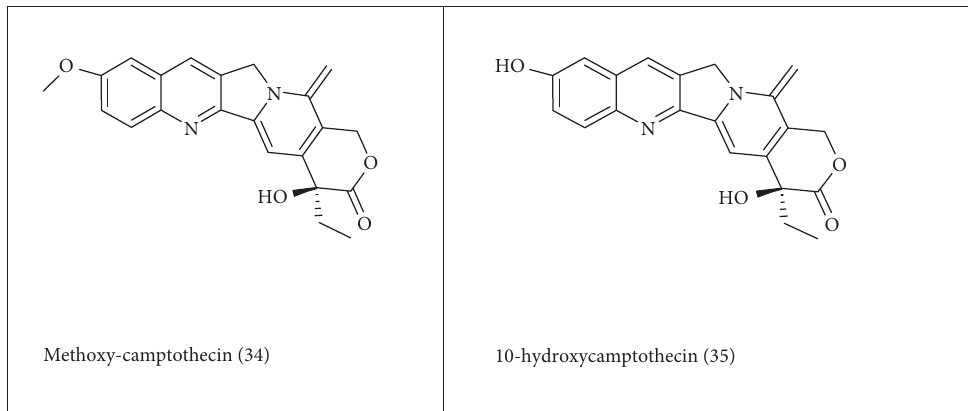
Figure 4: Chemotherapeutic agents obtained from